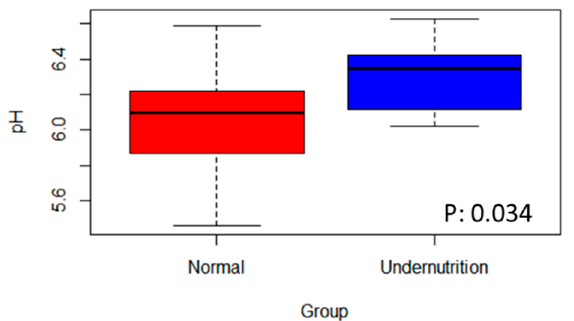
Figure 5. The difference in stool’s pH between normal and undernutrition group.